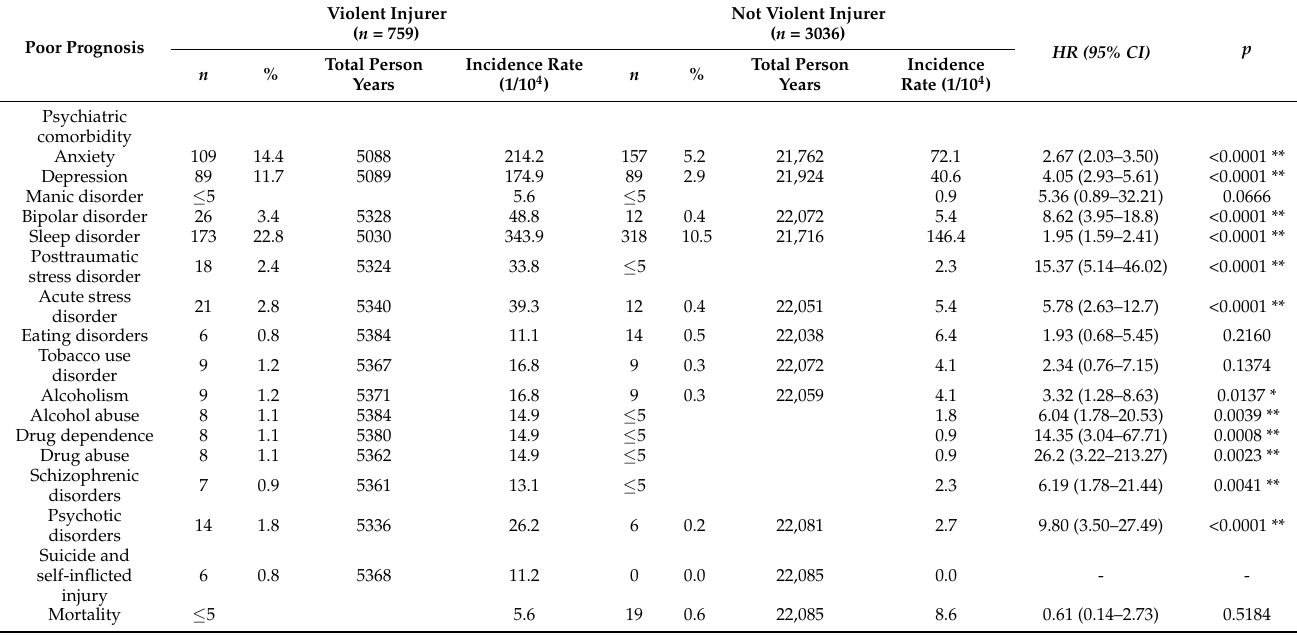
Table 4. Comparison of the risk of mental illness and poor prognosis between victims of violence and those without violence (children and adolescent,